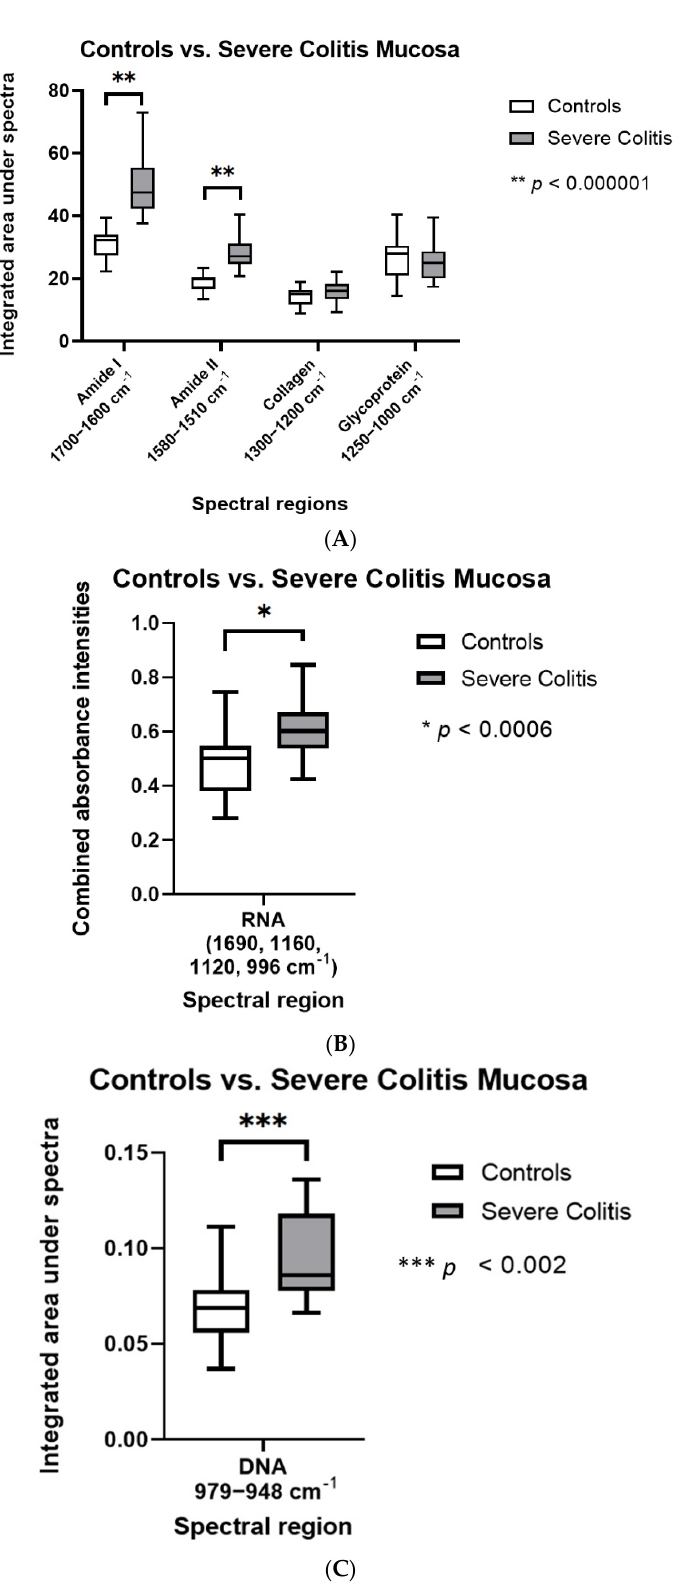
Figure 3. Quantitative comparison of the biochemical composition between the mucosa of control and severe colitis. ( A ) Integrated area under the bands representing protein, collagen, and glyco- protein. ( B ) Integrated area under the bands representing RNA. ( C ) Integrated area under the band representing